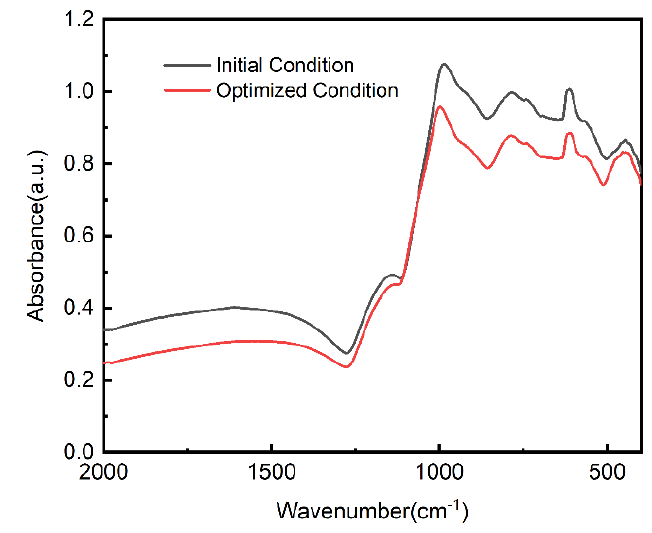
Figure 9. FTIR spectra of SiO 2 thin films under optimized conditions and initial conditions.